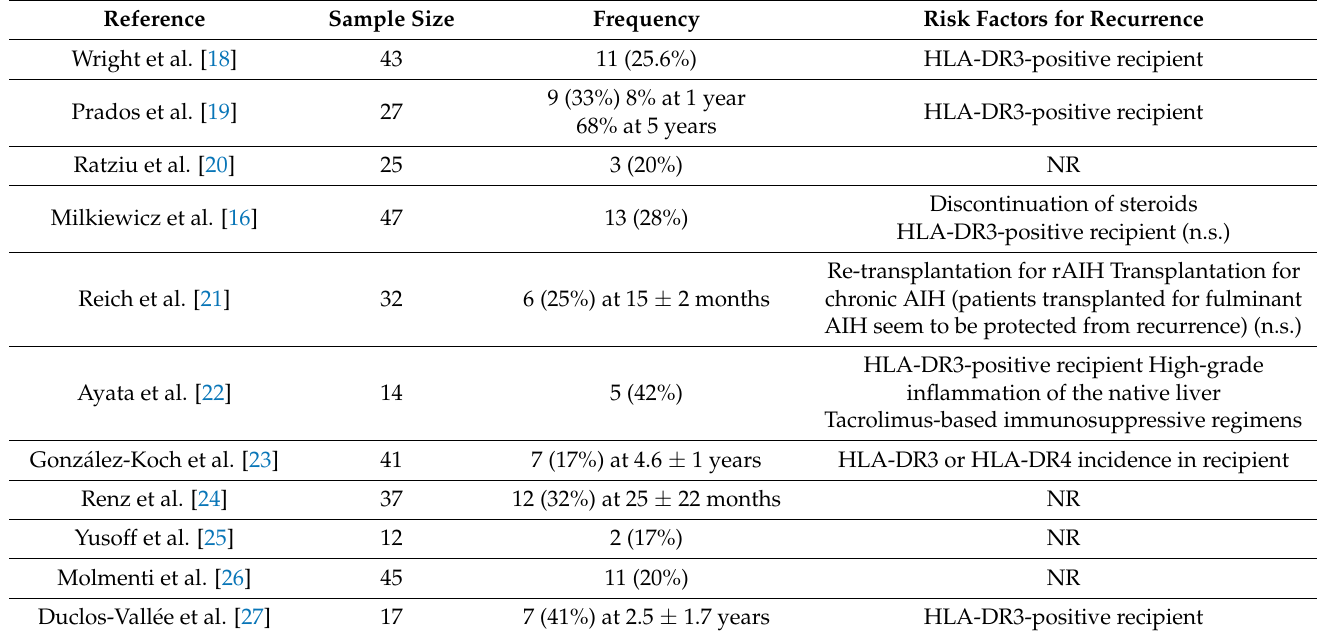
Table 1. Frequency and risk factors for recurrence of Autoimmune Hepatitis after liver